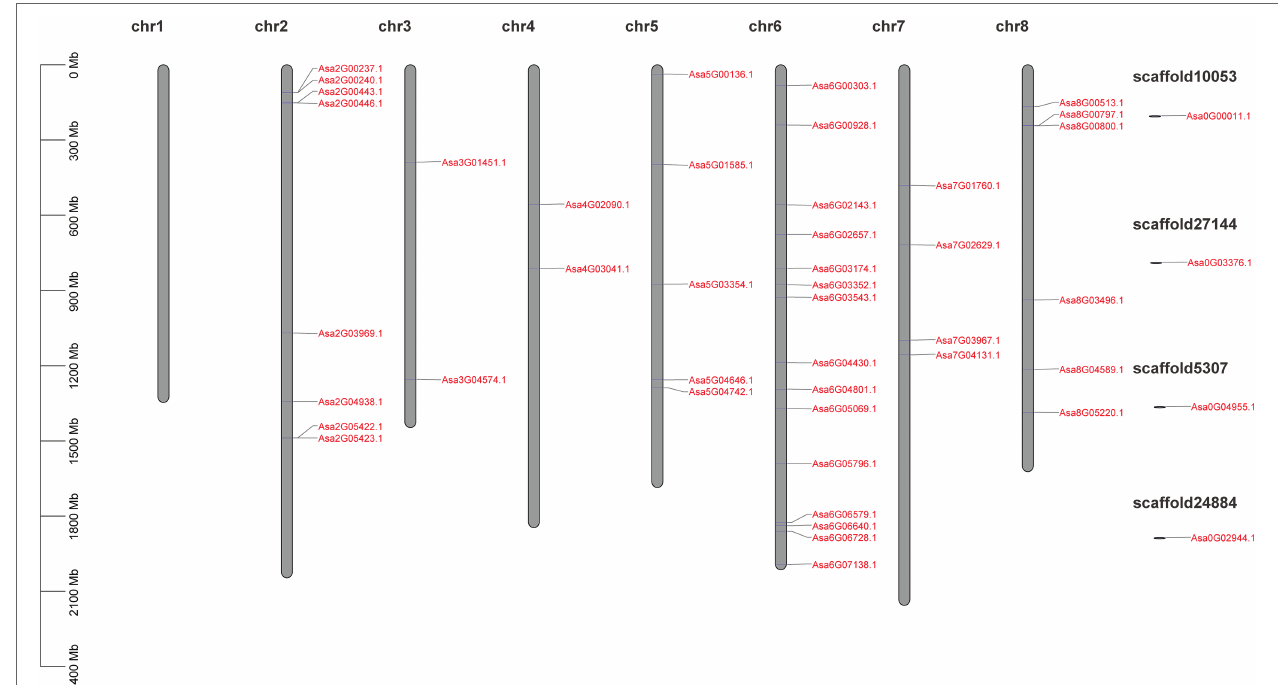
FIGURE 1 | Schematic representation of the chromosomal distribution of the AsGRAS genes. Vertical bars represent garlic chromosomes. The chromosome number is mentioned above each chromosome. The scale on the left represents chromosome length